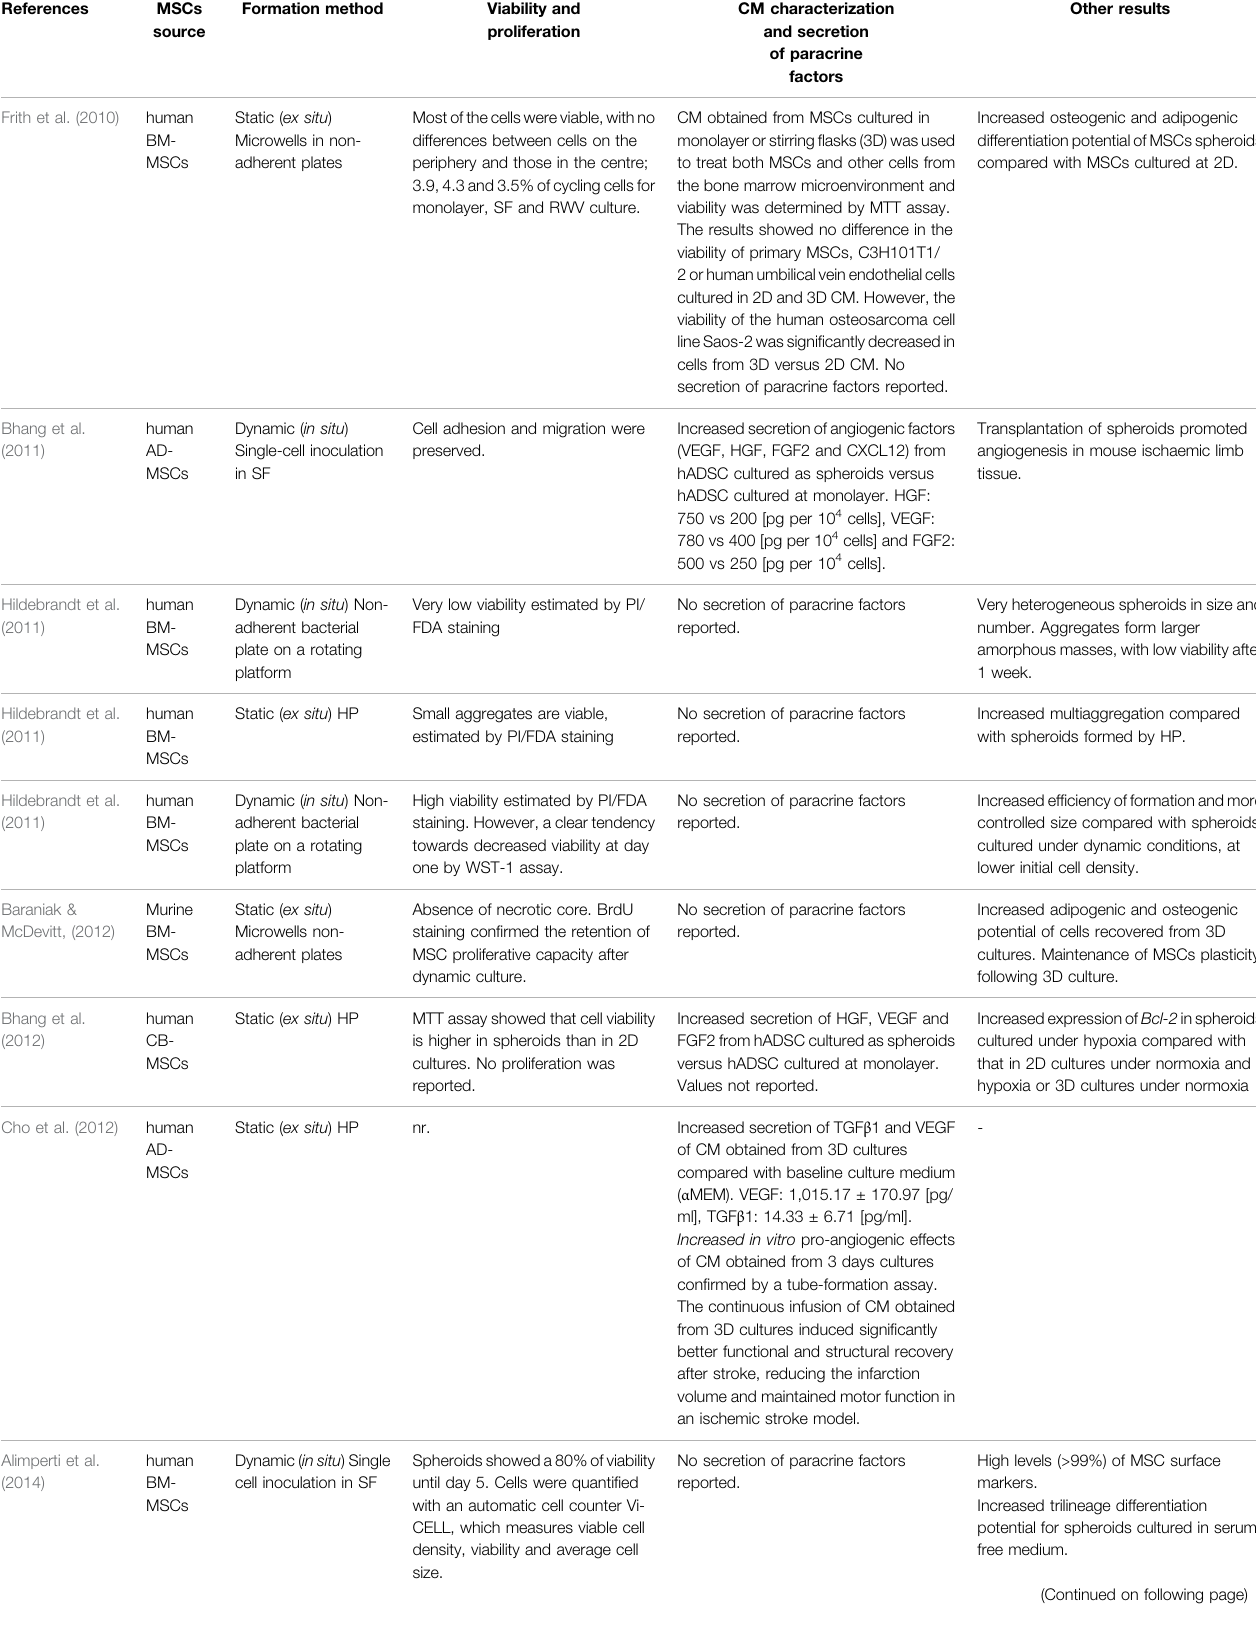
TABLE 2 | Comparison of different studies reporting static and dynamic methods of spheroid formation and their impact on the CM pro fi